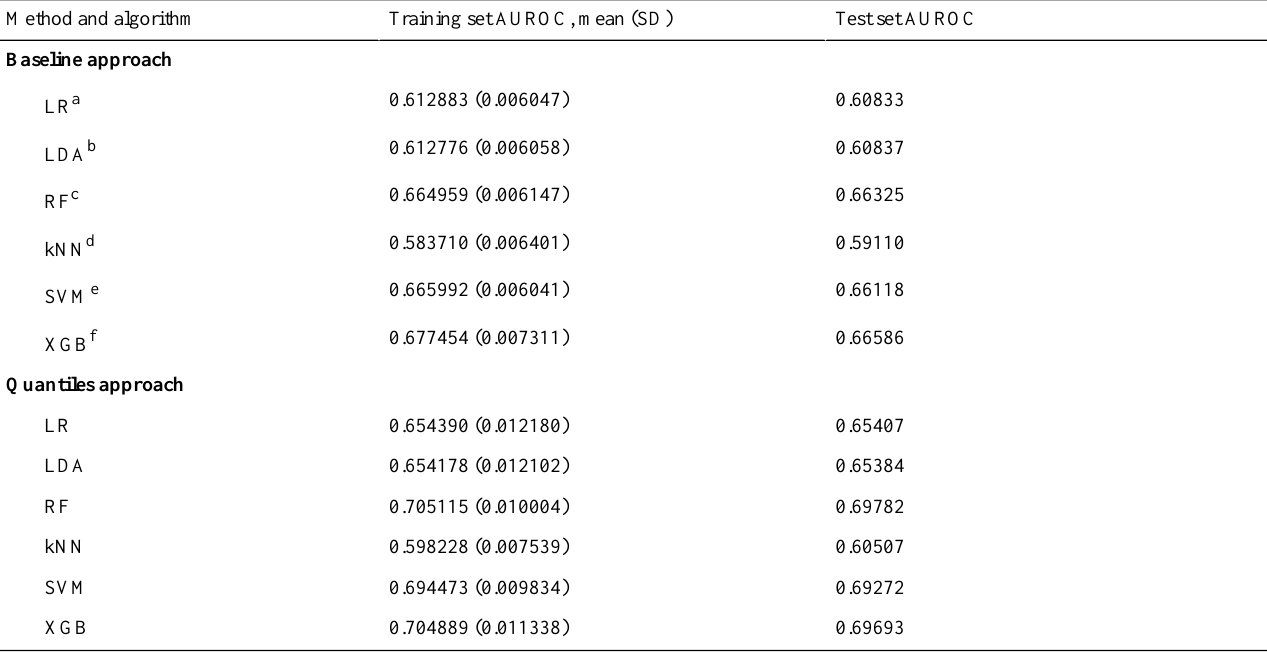
Table 11. Performance of the length of stay model results based on the area under the receiver operating characteristic curve (AUROC).